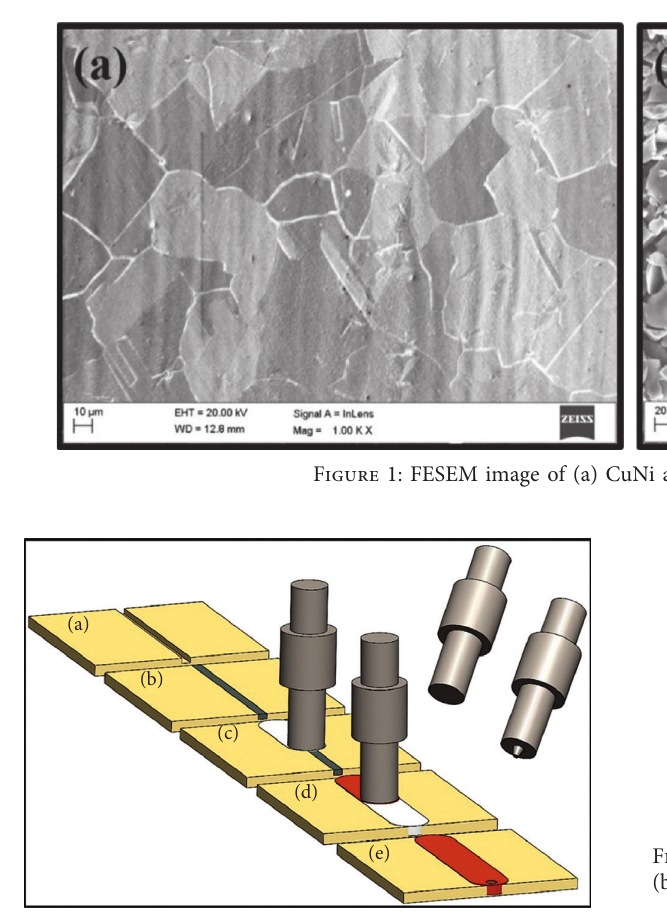
Figure 2: Friction stir processing and different stages: (a) preparation of groove; (b) charging the groove with ceramic particles; (c) processing via tool without pin; (d) processing via tool with pin; (e) processed plate.